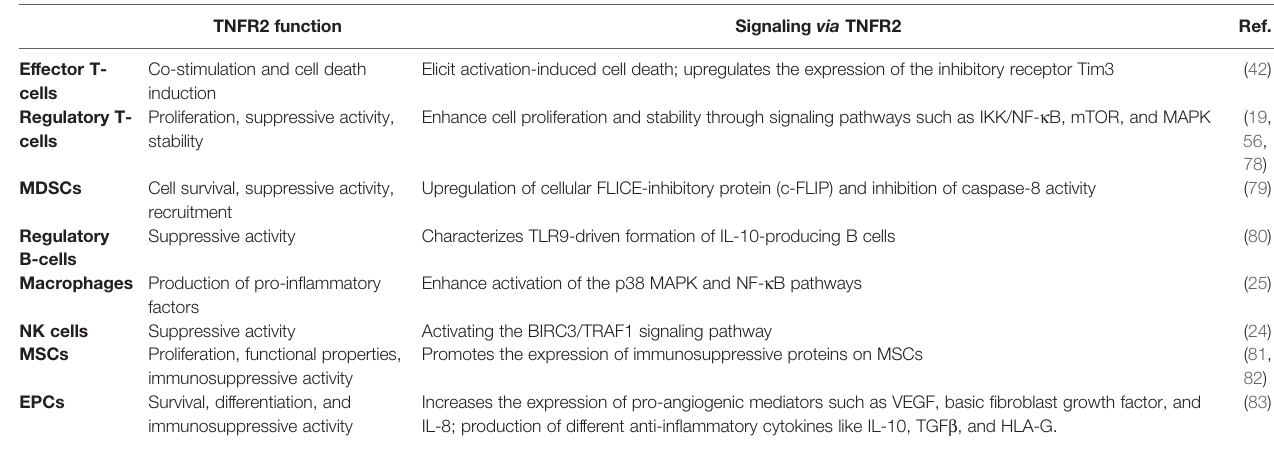
TABLE 1 | TNFR2-mediated signaling and TNFR2 function in immune cells. TNFR2